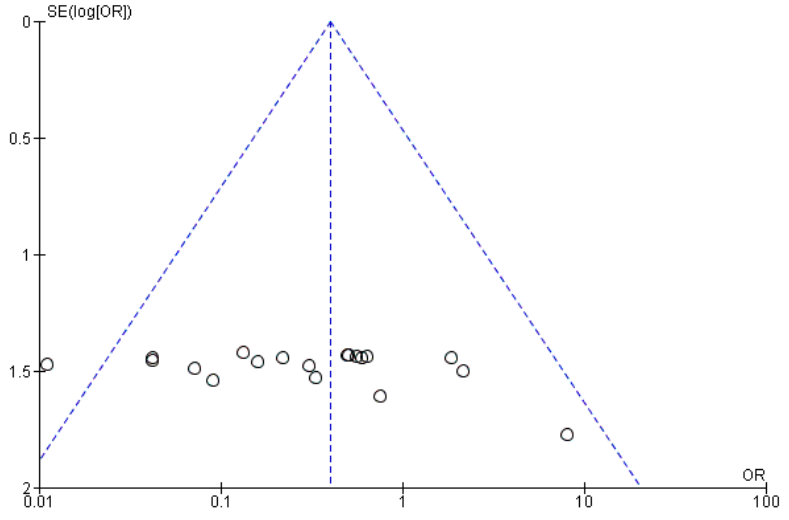
Figure 5. Funnel plot showing no publication bias.